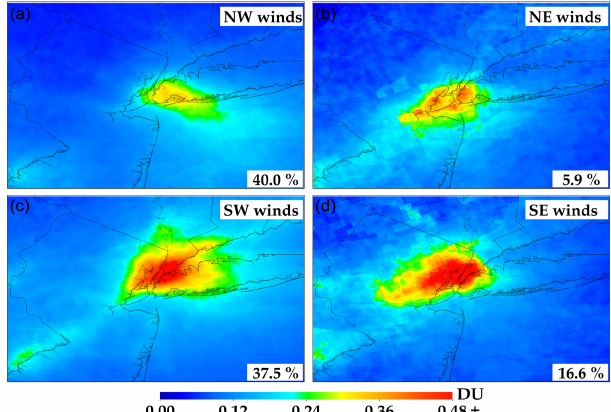
Figure 11. TROPOMI NO 2 plumes over New York City (May 2018–December 2019) segregated into 100m wind direction quadrants northwest (a) , northeast (b) , southwest (c) , and south- east (d) . The percentages of each direction are shown at the bottom right corner of each panel.